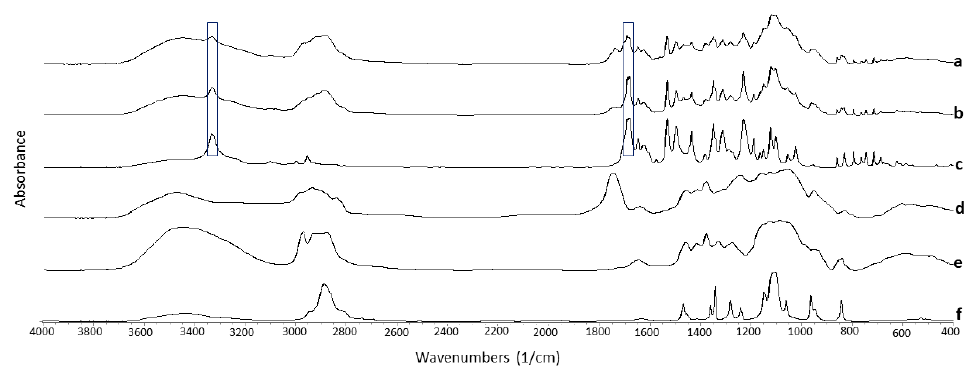
Figure 5. FTIR spectra. Key: ( a ) 3D printed minitablets, ( b ) Physical mixture, ( c ) Unprocessed NFD, ( d ) Unprocessed HPMCAS, ( e ) Unprocessed HPC, and ( f ) Unprocessed PEG 4000. Peak shifts are highlighted within boxes.